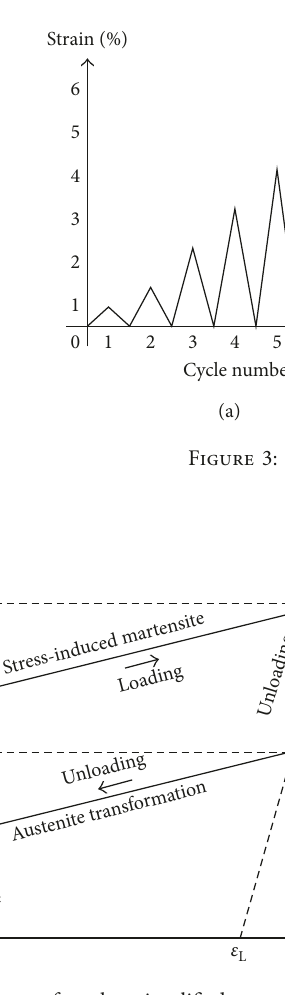
Figure 5: Diagram for the stress-strain response of real SMA material.